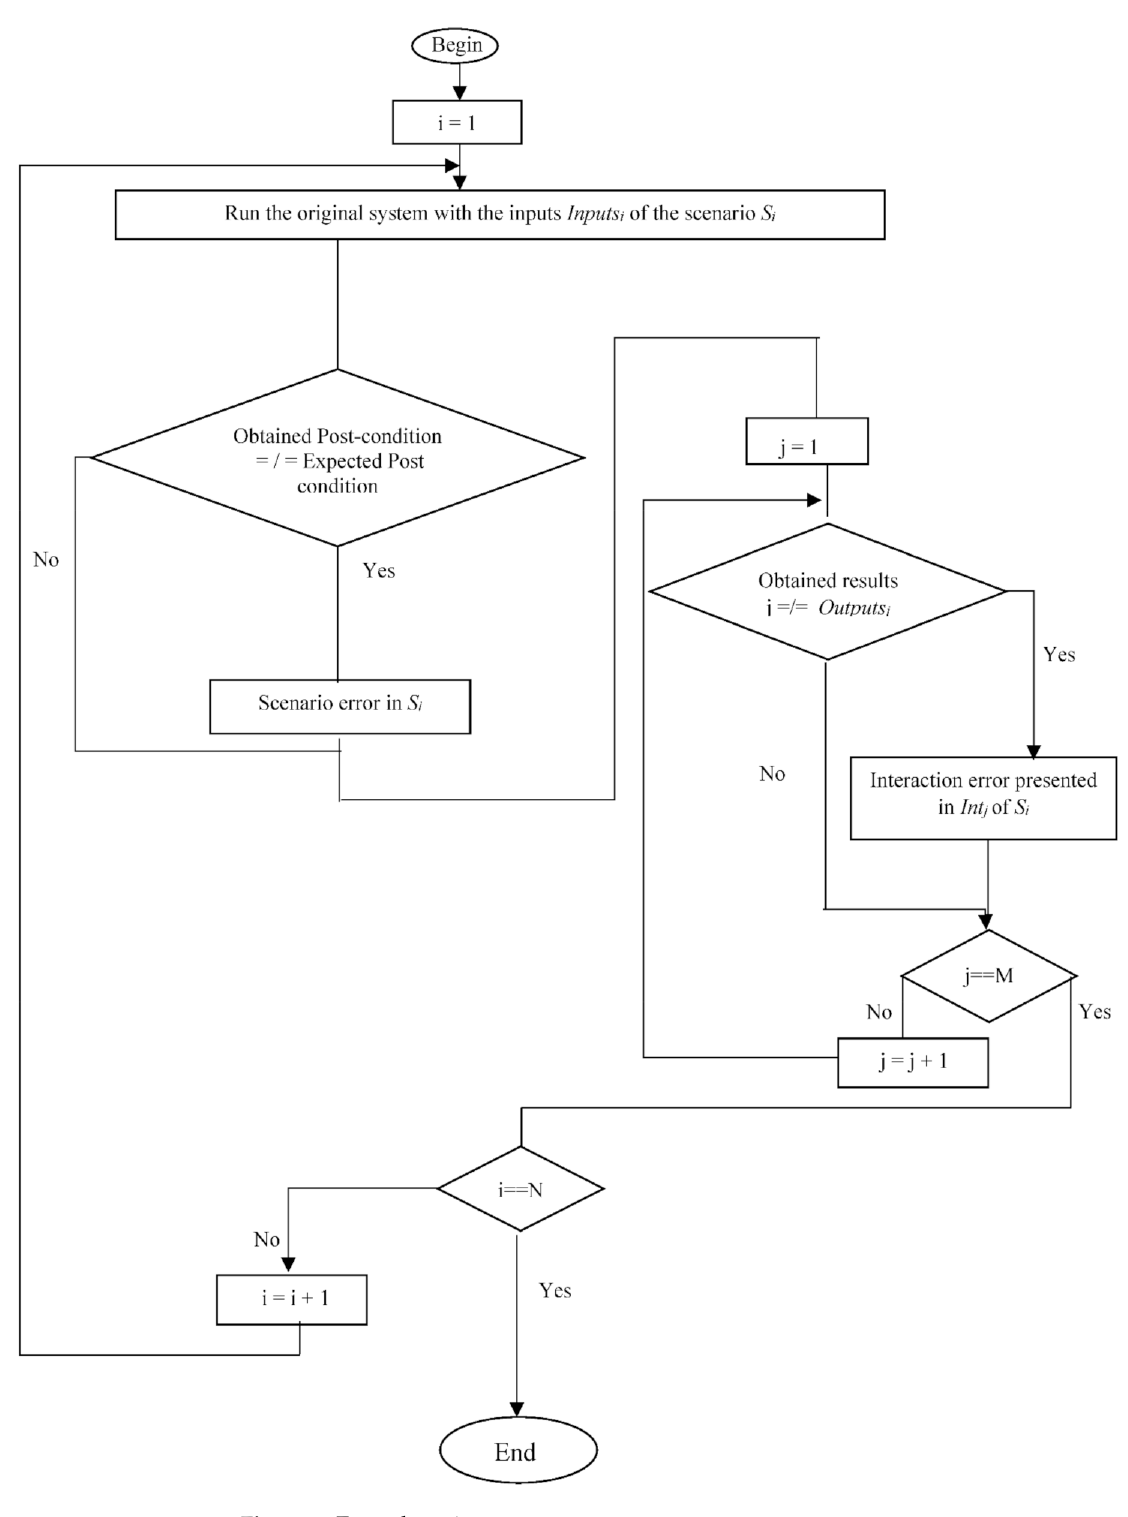
Figure 3. Error detection